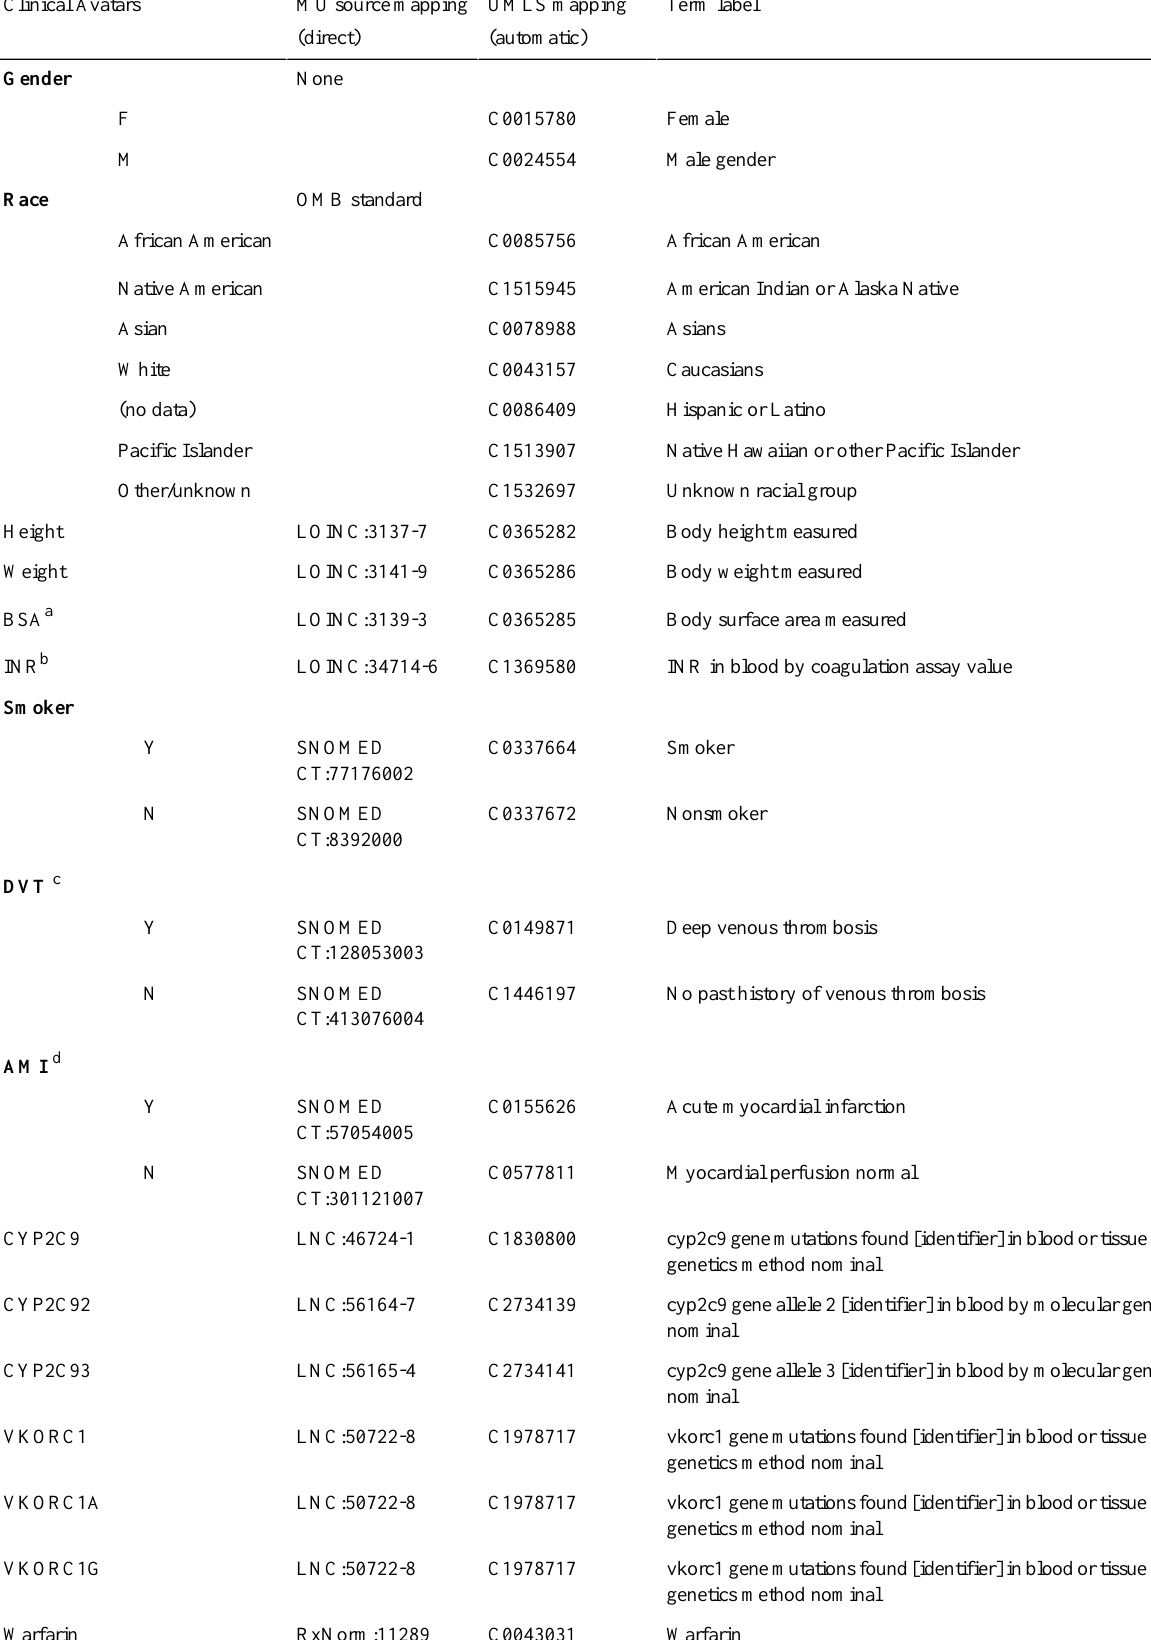
Table 2. Clinical Avatars data mapped to the UMLS via MU